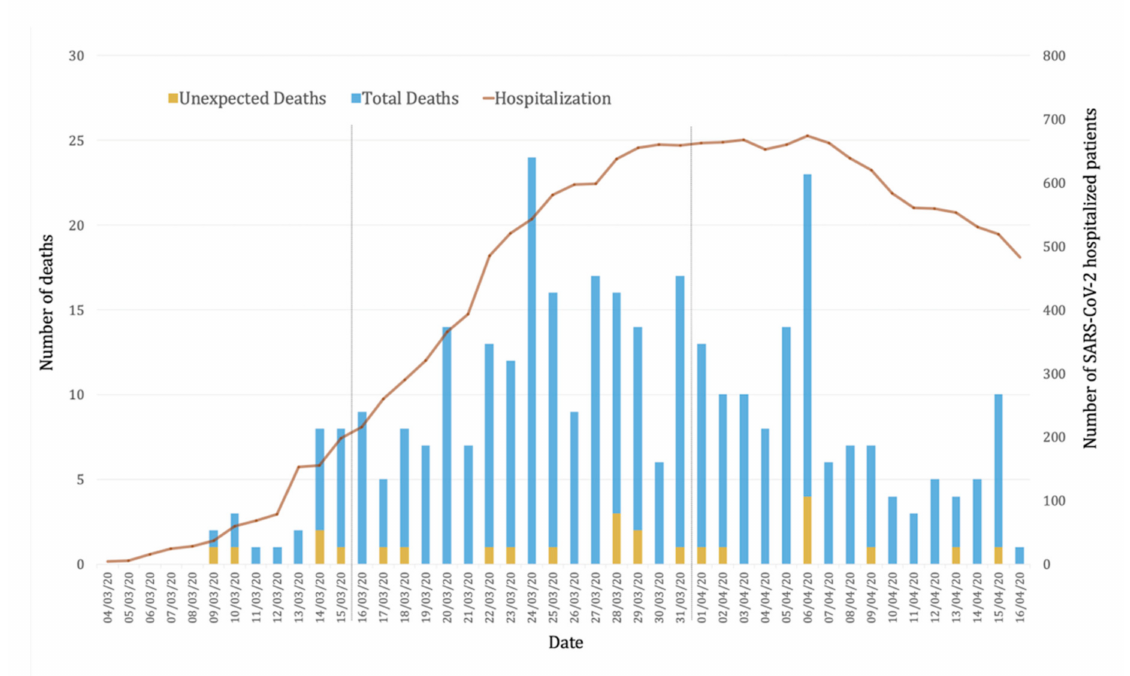
Figure 1. In-hospital mortality in patients with SARS-CoV-2 infection during the study period. The daily number of unexpected deaths (yellow), non-unexpected deaths (blue) and number of COVID-19 hospitalized patients are represented and divided by fortnight. Table 3. Univariable analysis between patients with unexpected death and non-unexpected